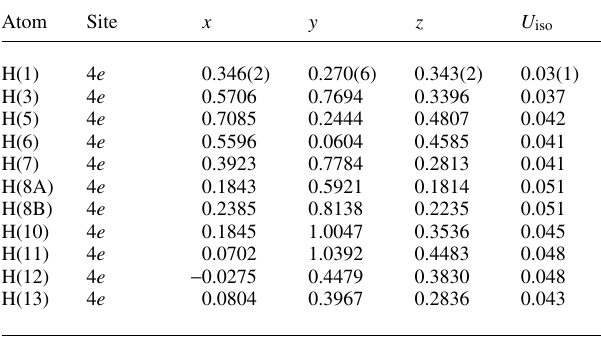
Table 2. Atomic coordinates and displacement parameters (in Å 2 )